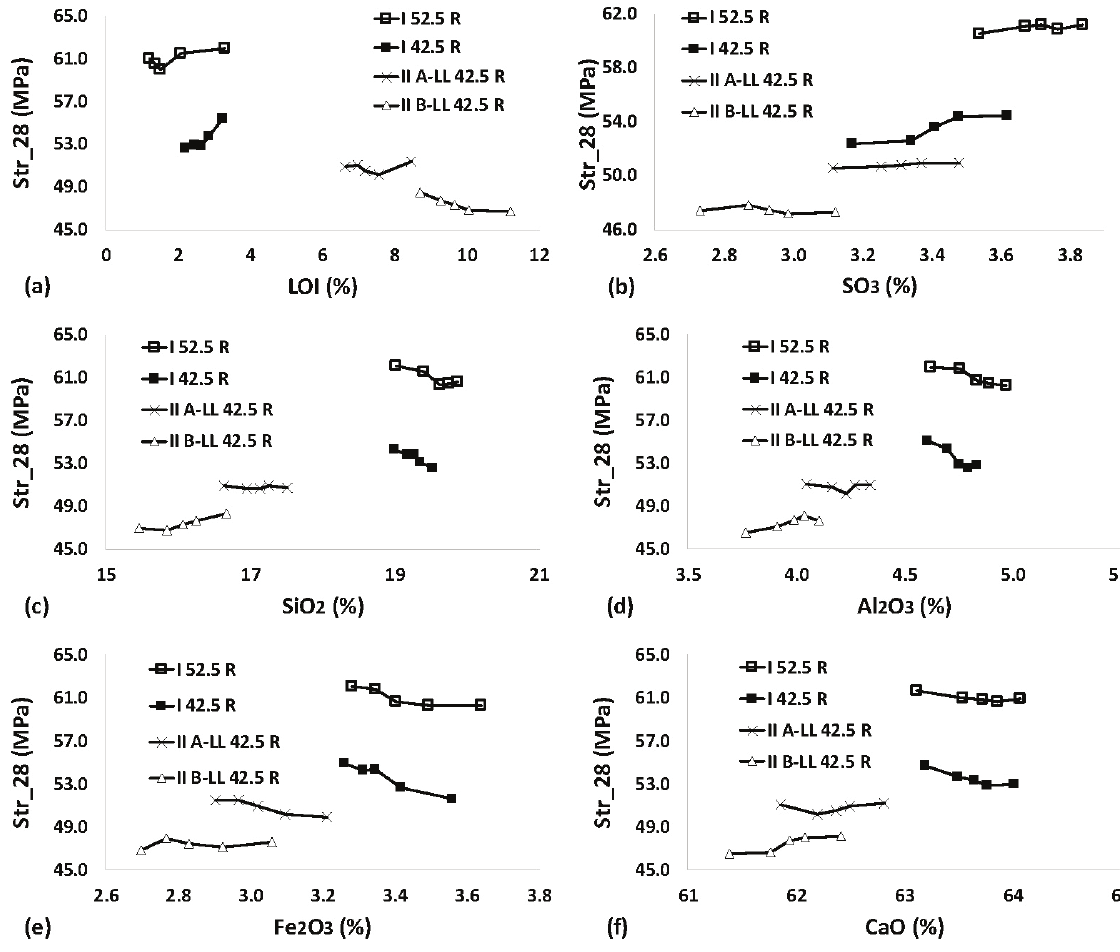
Fig. 5 – Effect of chemical characteristics on